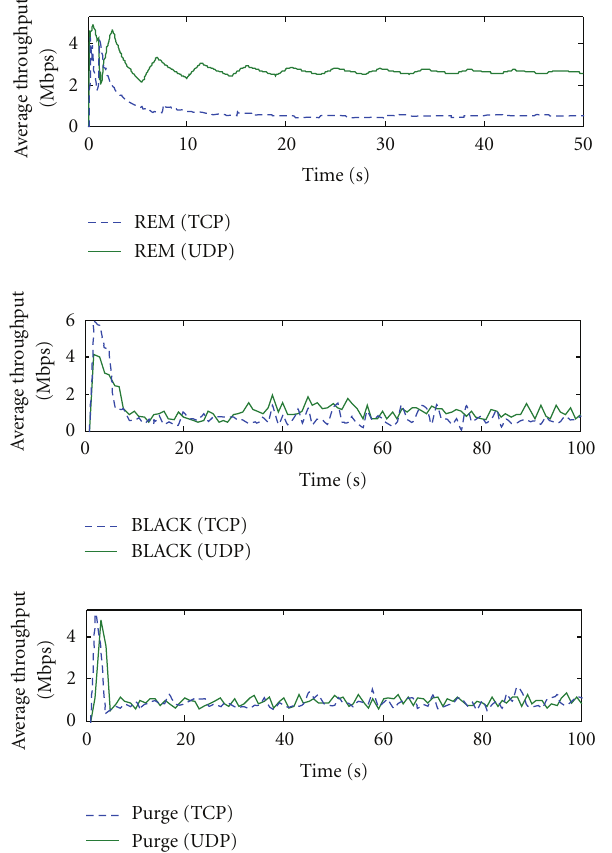
Figure 6: Rate allocation of REM, BLACK, and Purge.